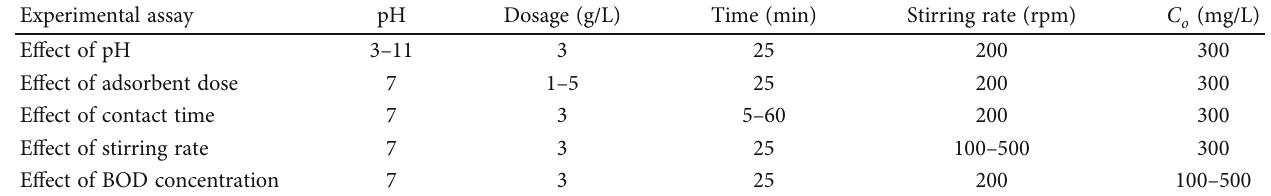
Table 1: Operating conditions of batch adsorption experiments for BOD